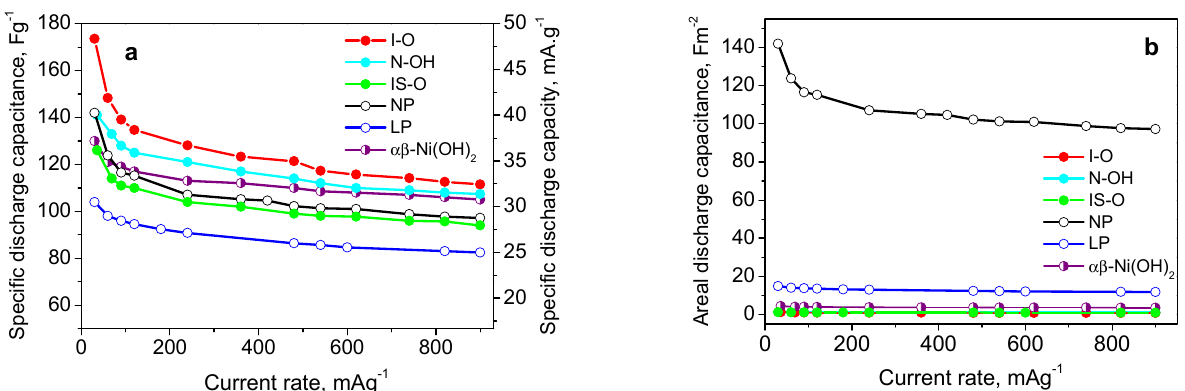
Figure 5. Specific discharge capacitance ( a ) and areal discharge capacitance ( b ) as a function of the current load of supercapacitor cells with different composite electrodes. For the sake of comparison, the discharge capacitance is also calculated in mA h g − 1 .